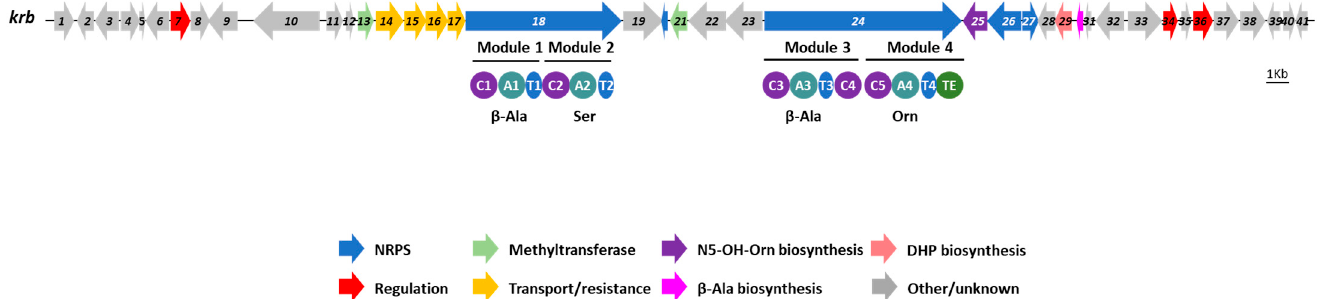
Figure 3. Biosynthetic gene cluster of kribbellichelins A–B ( krb ). The modules and domains present in the NRPS genes ( krb18 and krb24 ) are depicted. The amino acids activated by each adenylation domain are indicated. (A): adenylation domain; (C): condensation domain; (T): thiolation domain; (TE): thioesterase domain.